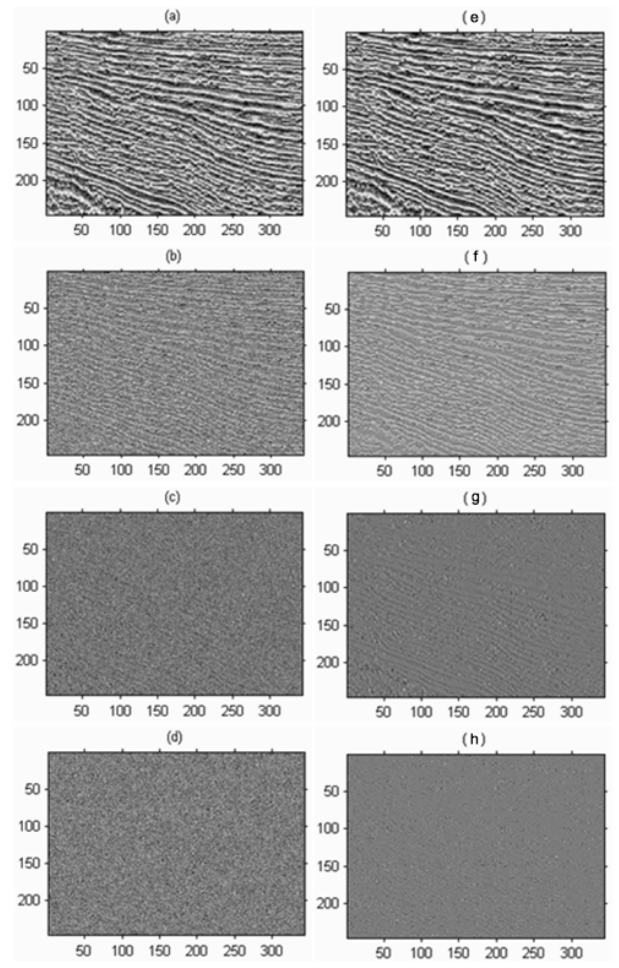
Figure 5. (a) Low-frequency structure image component cA. (b) Lateral high-frequency detail component cH. (c) Longitudinal high-frequency detail component cV. (d) Diagonal high-frequency detail component cD. (e) The results obtained by bilateral texture filtering of (a) . (f) Obtaining the results after detail enhancement of (b) . (g) Obtaining the results after detail enhancement of (c) . (h) The results are enhanced by the detail enhancement of (d) .